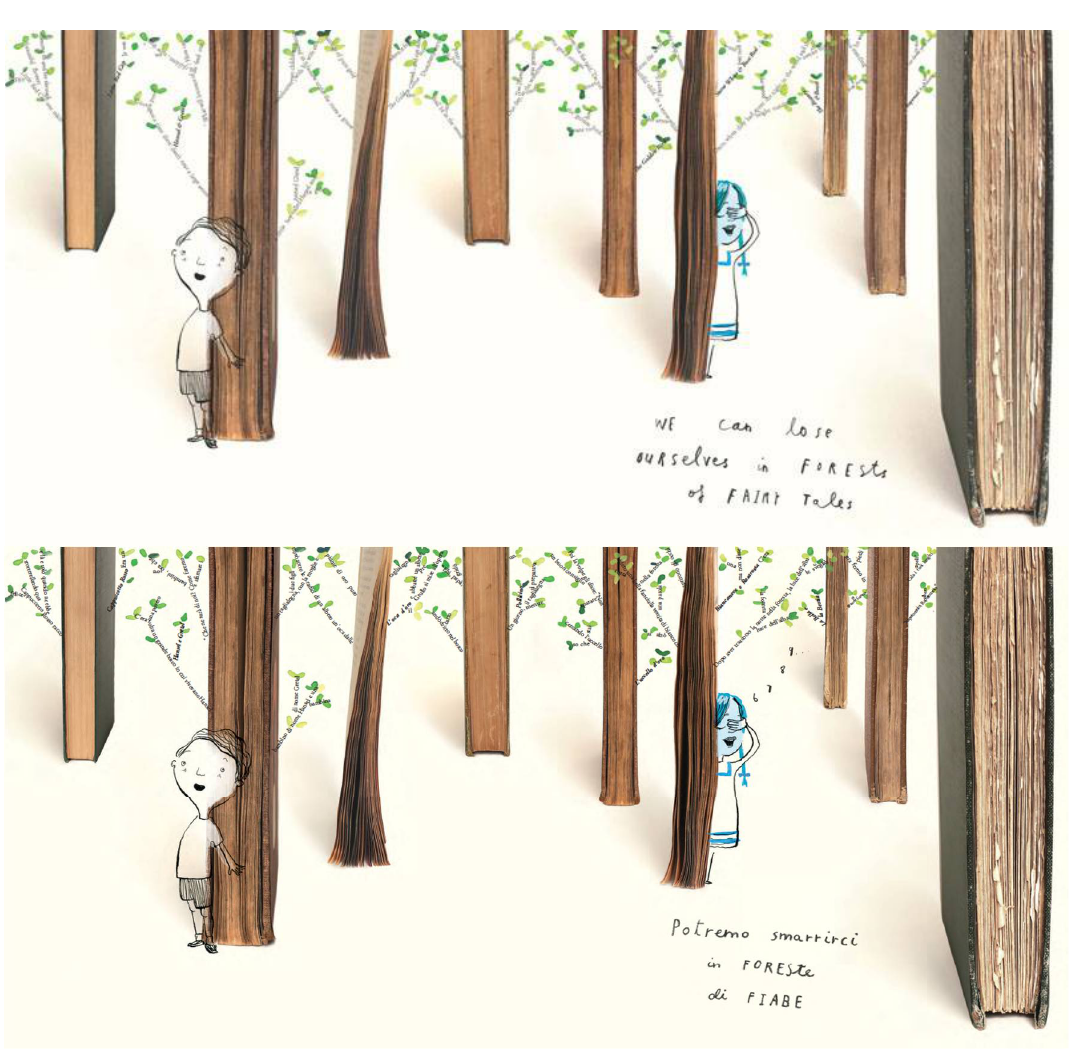
Figure A17. Jeffers O.; Winston S. A child of books, Walker Books, London, 2016; Jeffers O; Winston S. La bambina dei libri, Lapis, Roma,